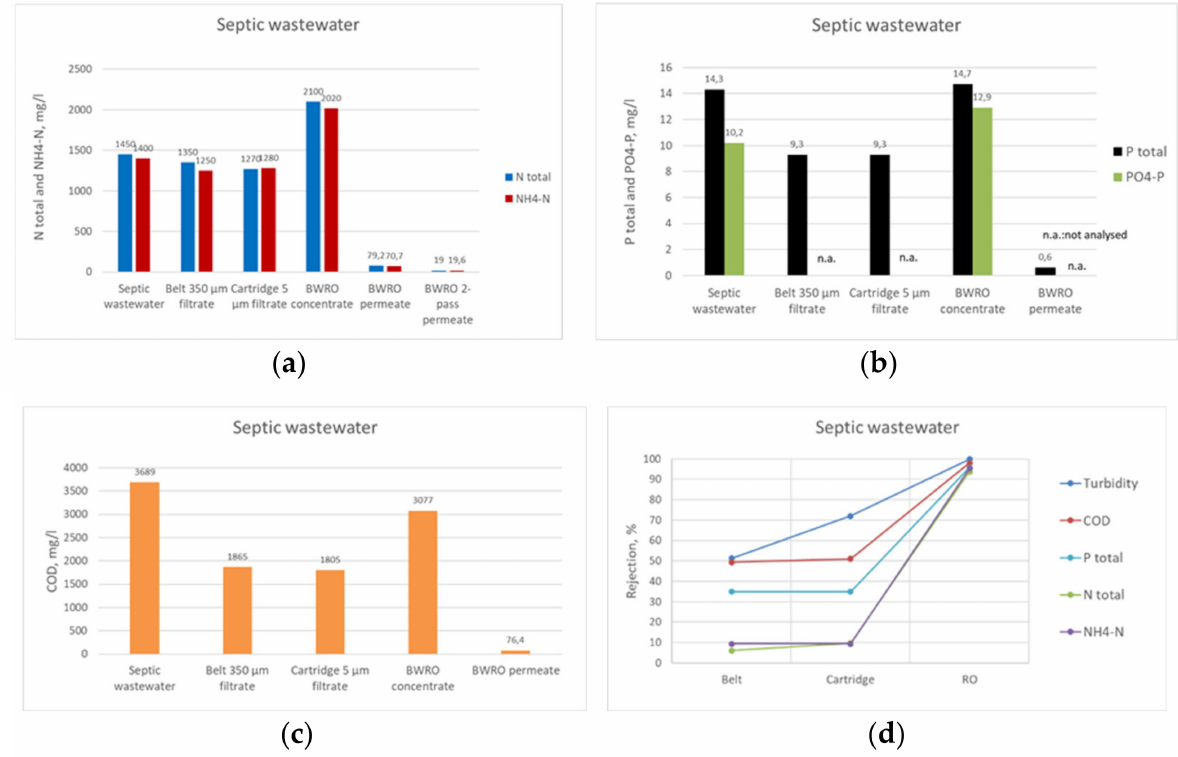
Figure 10. Results of piloting the septic wastewater; ( a ) N total and NH 4 -N contents, ( b ) P total and PO 4 -P contents, ( c ) COD contents, and ( d ) rejections of turbidity, COD, P total, N total, and NH 4 -N